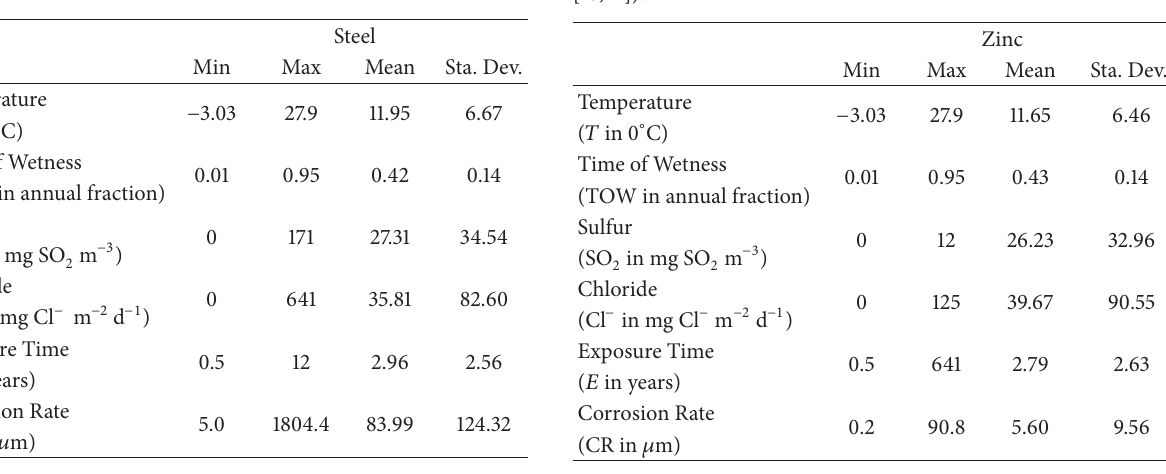
Figure 8: GP zinc expression no. 2. Table 1: The steel dataset used in the experiments (adapted from [10, 11]).